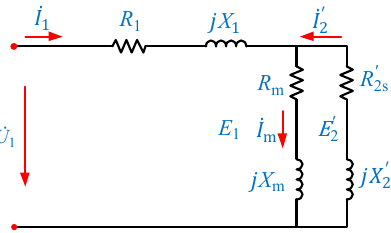
Figure 5. Single phase equivalent circuit of the rotary part.